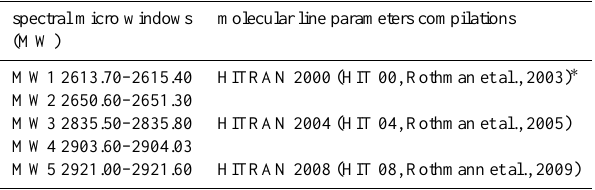
Table 2. Test sites of this study and corresponding range of inte- grated water vapor according to National Center for Environmental Prediction data selected for clear-sky days (FTIR measurement con-